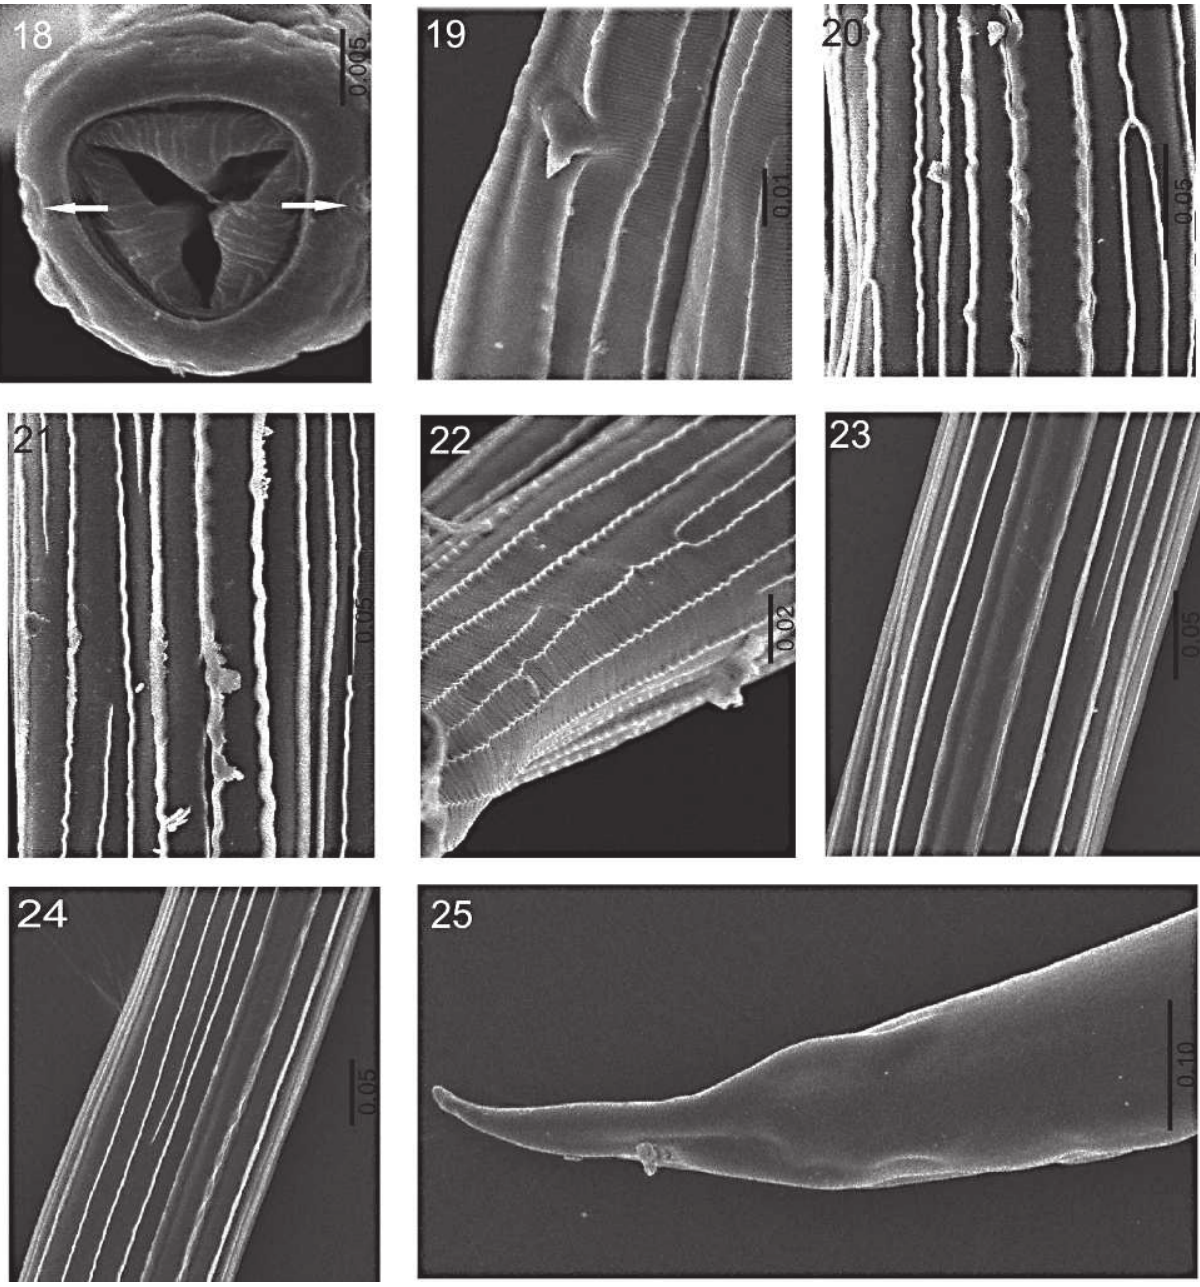
18-25. – 18. Head (apical view) showing subtriangular buccal ring and amphids (arrows). 19. Deirid. 20-24. Synlophe showing inter- rupted and confluent ridges: 20-21, behind oesophago-intestinal junction; 22-23, at level of anterior quarter of body; 24, at level of mid- body. 25. Female tail devoid of